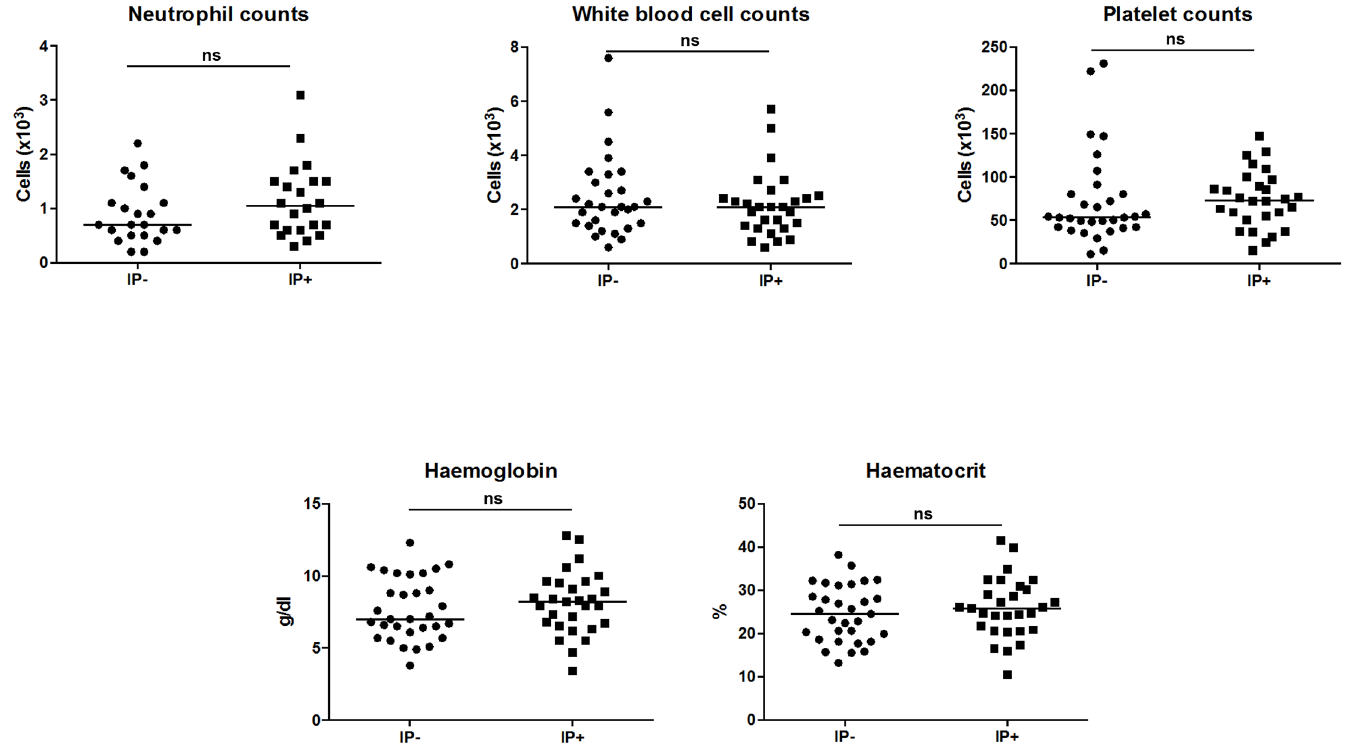
Fig 2. WBC = white blood cells; Plt = platelets; Hct = hematocrit; Hb = haemoglobin. Normal range: neutrophils(x10 3 )/ μ l = 2–7.5, platelets (x10 3 )/ μ l = 150–450; white blood cells (x10 3 )/ μ l = 4.5–10.5; Hct (%) = 35–60; hb (g/dl) = 11–18,Neutrophil (x10 3 ) These parameters were measured in the blood of VL patients without intestinalparasite co-infections (IP-) and in VL patients co-infectedwith intestinalparasites (IP+), using a CELL-DYN1800 Haematology Analyser, USA. Statistical significancewas established using a Mann-Whitney test, ns = not significant( p < 0.05).